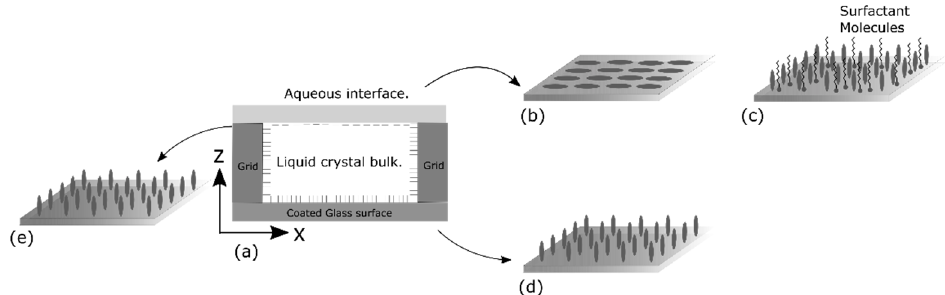
Figure 1. A schematic diagram depicting the liquid crystal biosensor film orientation at interface and surfaces. ( a ) The cross-section view of liquid crystal film. ( b ) Pure water induces the planar alignment of liquid crystal molecules at the aqueous interface. ( c ) Presence of surfactant results in the transition to the homeotropic alignment at the aqueous interface. ( d ) The functionalized glass induces the homeotropic alignment. ( e ) The coated gold surface induces the homeotropic alignment.